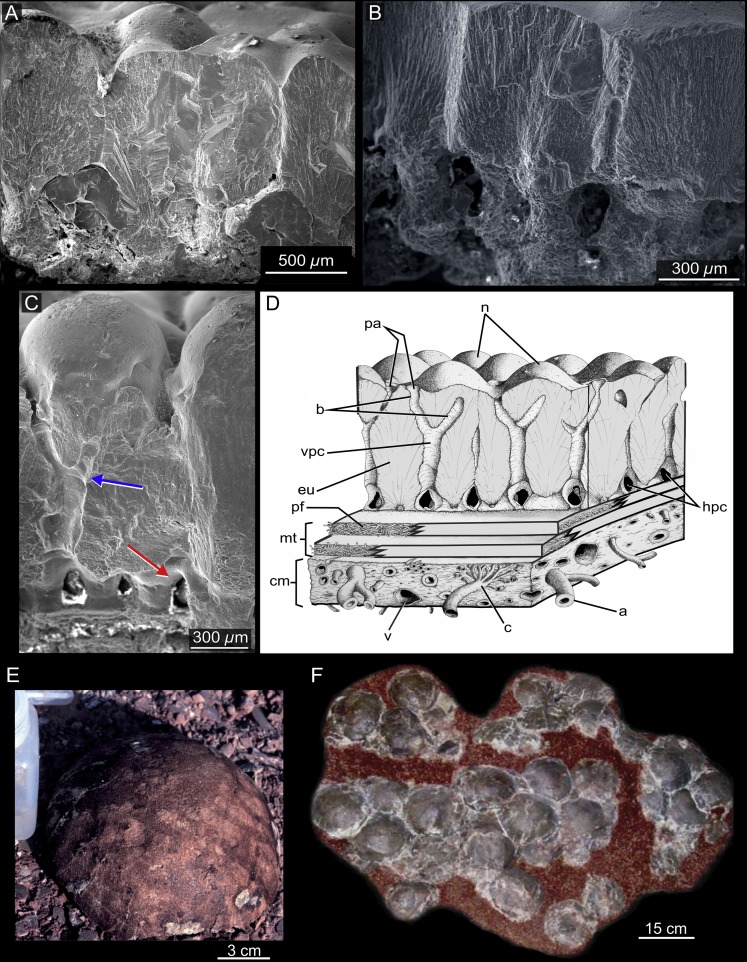
Auca Mahuevo nesting site.(A–C) Radial section of titanosaur eggshell fragments (From Grellet-Tinner, Chiappe & Coria, 2004; Grellet-Tinner & Zaher, 2007). Note in (C) the transverse Y-shaped vertical pore canals (blue arrow) and the horizontal network system (red arrow). (D) Schematic interpretation of an eggshell from AM L#4, according to Grellet-Tinner, Chiappe & Coria (2004) SEM observations (modified from Grellet-Tinner, Fiorelli & Salvador, 2012). a, arteries; b, branches of pore canal; c, capillaries; cm, corioallantoid membrane; eu, eggshell unit; hpc, horizontal pore canals; mt, membrana testacea; n, node on outer eggshell surface; pa, pore aperture; pf, protein fibers of the membrana testacea; v, veins; vpc, vertical pore canals. (E) Complete egg AM L#3. (F) Egg clutch recovered from AM L#3 (LACM 149648; from Grellet-Tinner, Chiappe & Coria, 2004). LACM, Natural History Museum of Los Angeles County.